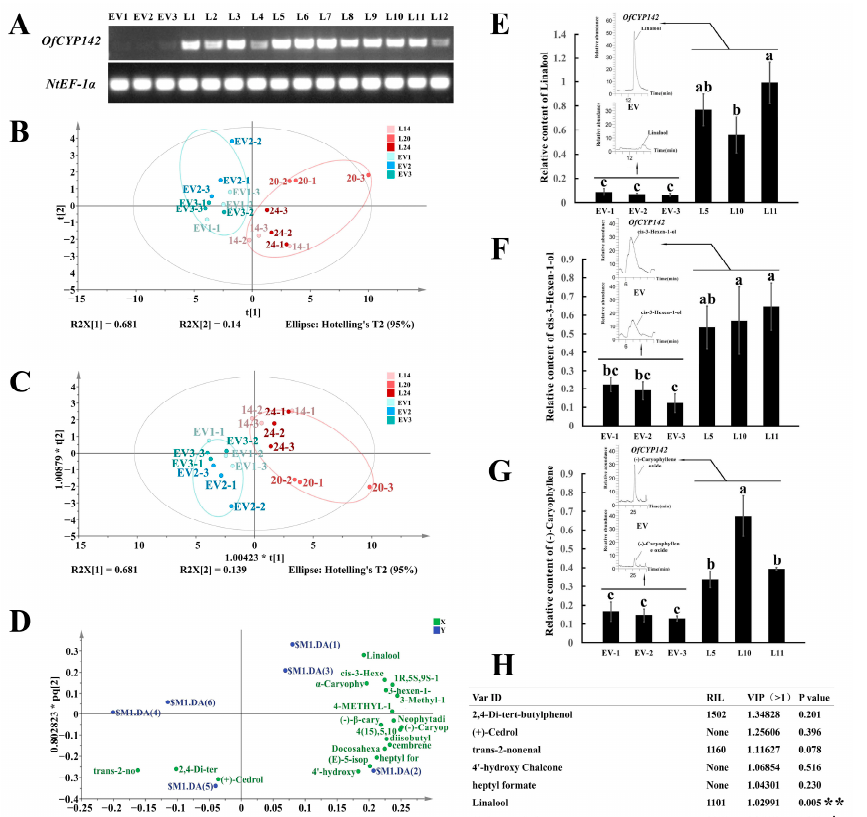
Figure 9. Functional characterization of OfCYP142 by stable transformation. ( A ) Semiquantitative RT-PCR to determine the expression intensity of OfCYP142 ; a fragment of the NtEF-1 α gene was amplified as the normalizer, EV1–3 denote different plant lines that were stably transformed with empty vectors, and L1–12 denote different plant lines that were stably transformed with 35S: OfCYP142 :GUS vectors. ( B ) Score scatter plot of the flower GC–MS profiles of two types of flowers with overexpression of OfCYP142 and empty vector in tobacco, determined with PCA-X analysis in SIMCA14.1. Each type of plants consisted of three replicates. ( C ) Score scatter plot of the flower GC–MS profiles of two types of flowers with overexpression of OfCYP142 and empty vector in tobacco, determined with OPLS-DA analysis in SIMCA14.1. ( D ) Loading scatter plot analysis of floral volatile organic compounds in plants that were stably transformed with 35S: OfCYP142 :GUS and empty vectors. ( E ) Floral composition analysis of linalool after stable transformation with 35S: OfCYP142 :GUS and empty vectors. ( F ) Floral composition analysis of leaf alcohol after stable transformation with 35S: OfCYP142 :GUS and empty vectors. ( G ) Floral composition analysis of (-)-caryophyllene oxide after stable transformation with 35S: OfCYP142 :GUS and empty vectors. ( H ) Information of key aromatic components selected based on VIP from OPLS-DA (VIP > 1); * significant difference at p < 0.05 and ** significant difference at p < 0.01. The lowercase letters above the columns represent the significant differences as assessed by Duncan’s test at the 0.05